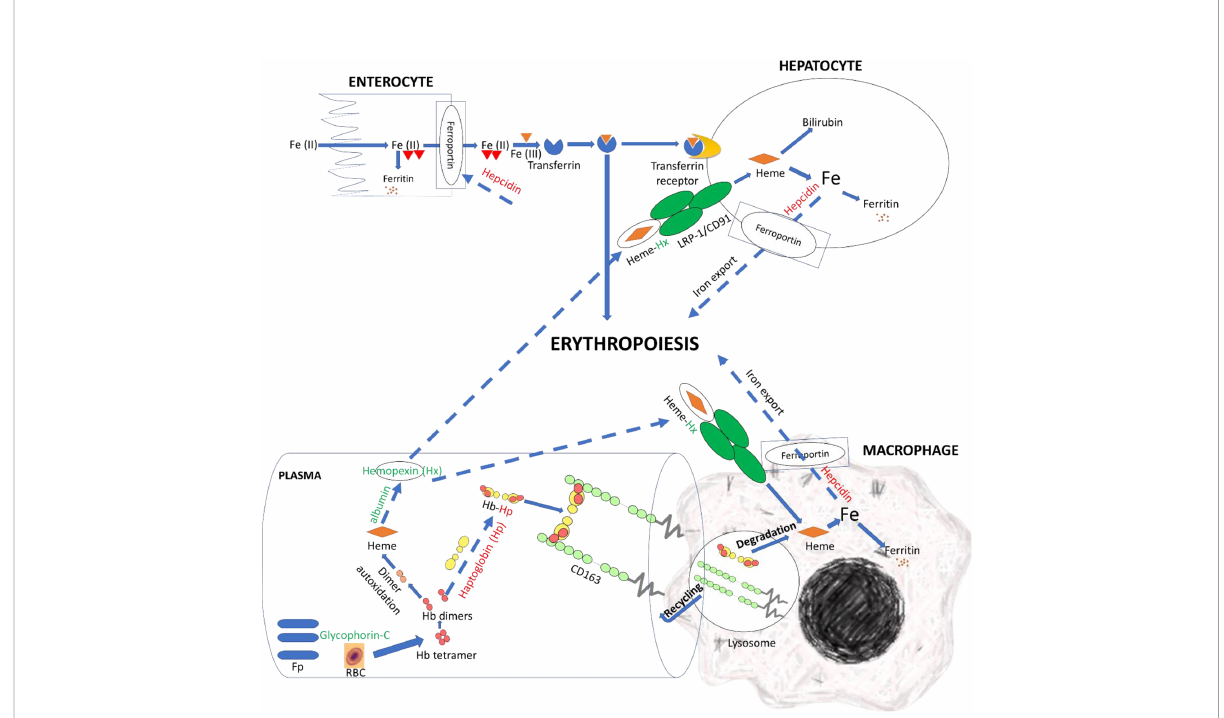
FIGURE 7 LncNATs complementary to hemolysis-related genes were DE in the resistant fi sh compared to susceptible fi sh on day 5 post-infection to promote clearance of free Hb and heme and enhance erythropoiesis. LncNATs of Hx, albumin, and glycophorin-C were upregulated in the resistant fi sh (green-coded), whereas lncNATs complementary to hepcidin and Hp were downregulated (red-coded). Glycophorin-C maintains the cell shape and membrane ’ s stability. Whereas Hp binds to Hb and transports it to the macrophages for catabolism. When Hp depletes, albumin transmits heme to Hx. The latter transports heme to the macrophage and hepatic cells, via receptor-mediated endocytosis, for catabolism. Low hepcidin expression allows iron export from macrophages and hepatocytes and iron import from enterocytes, promoting erythropoiesis. The proposed model suggests regulation of genes preventing pro-in fl ammatory effects of heme and reducing iron availability for bacterial growth in resistant fi sh. Dashed arrows indicate processes suggested in this study, whereas solid arrows refer to processes supported by information from the